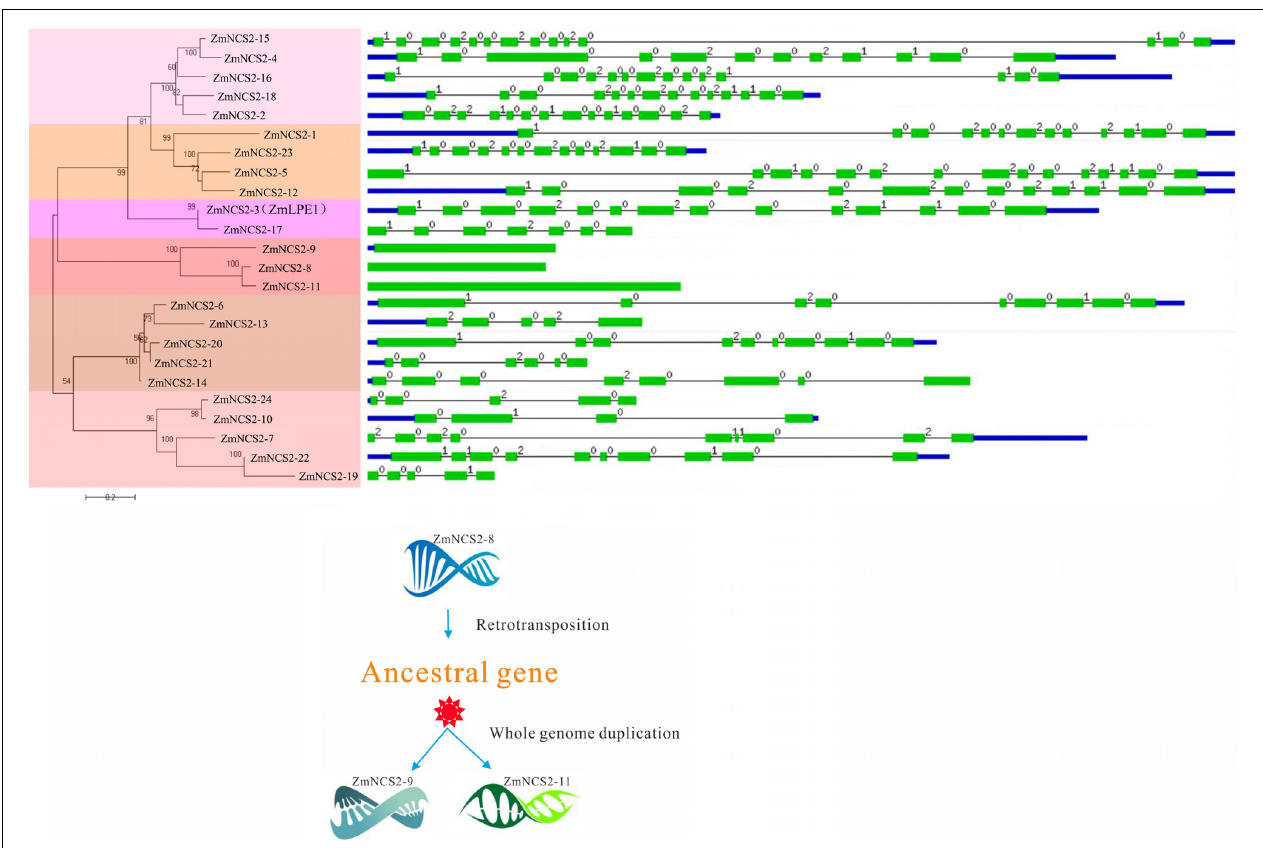
FIGURE 5 | Phylogenetic and gene structural analyses of the maize NCS2 family. Phylogenetic tree of all Zea mays NCS2 genes, intron/exon structures of 24 NCS2 genes, and duplication of an intronless gene caused by retrotransposition.